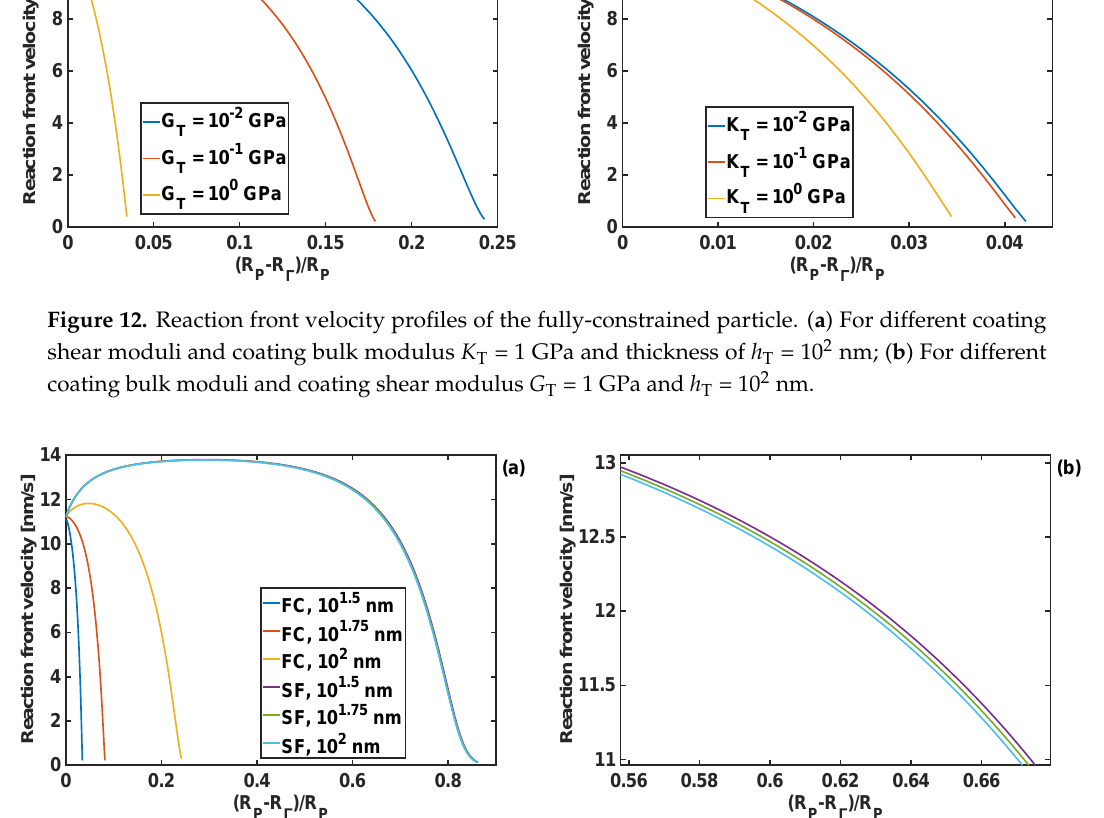
Figure 13: Reaction front velocity profiles for particles with different coating thicknesses and subject to different boundary conditions (fully-constrained (FC) and stress-free (SF)); coating shear modulus of 10 −2 GPa and bulk modulus of 10 0 GPa; (a) full range; (b) limited range - zoomed-in velocity profiles for SF boundary conditions.